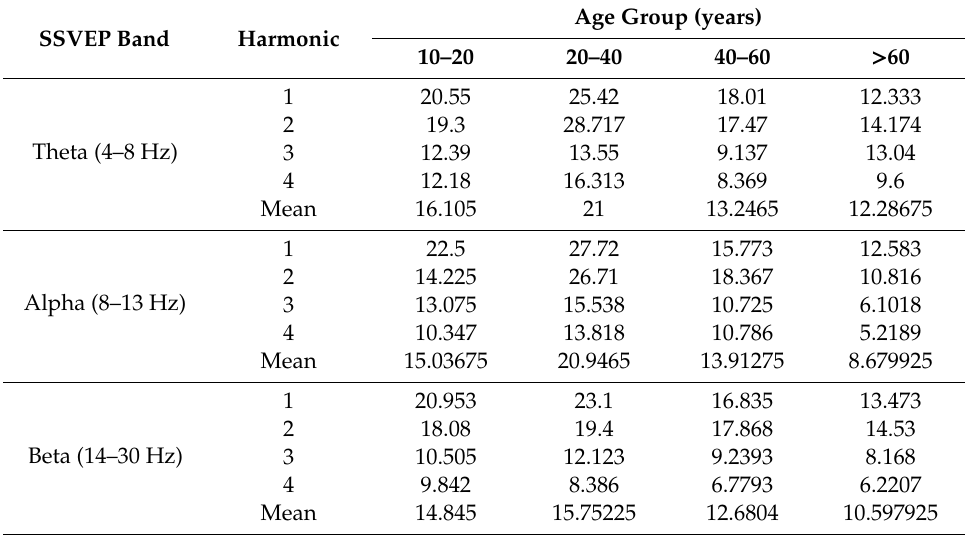
Table 2. Band power (dB / Hz) of SSVEPs evoked by theta, alpha, and beta frequencies.